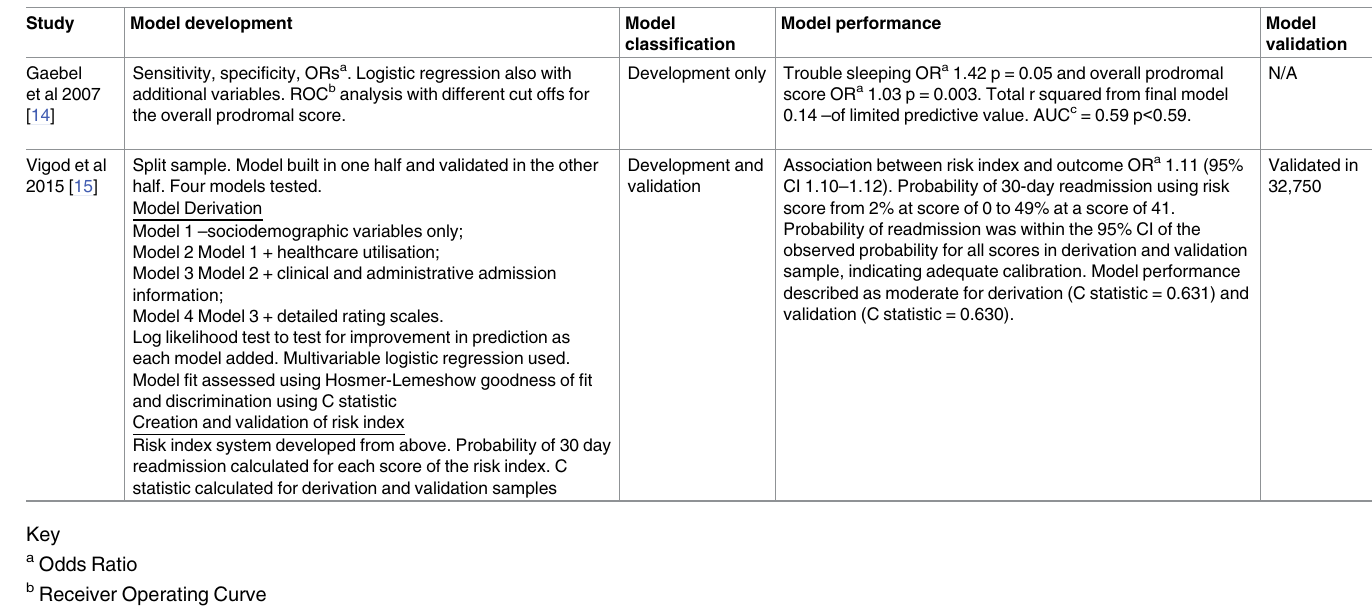
Table 2. Type of study and